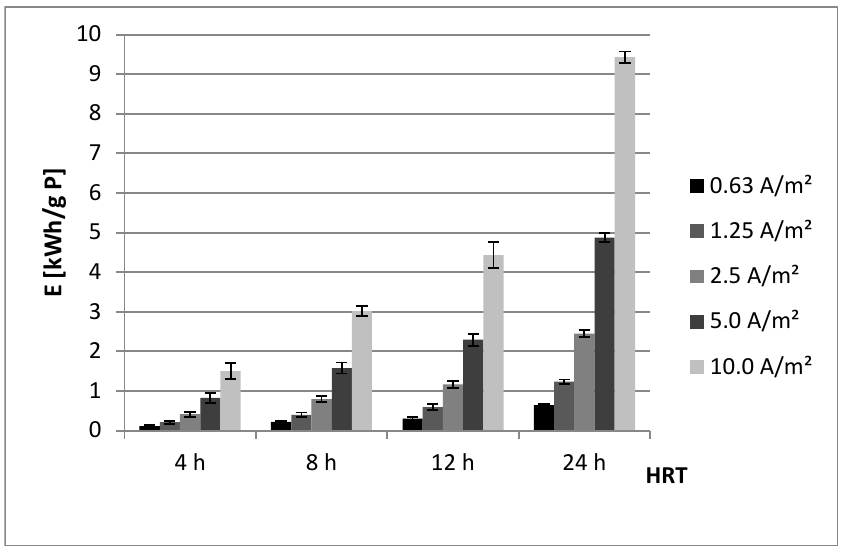
Figure 4. Influence of current density and hydraulic retention time (HRT) on electric power consumption in the removal of phosphorus compounds in the rotating electrochemical disk contactor (mean and standard deviation).